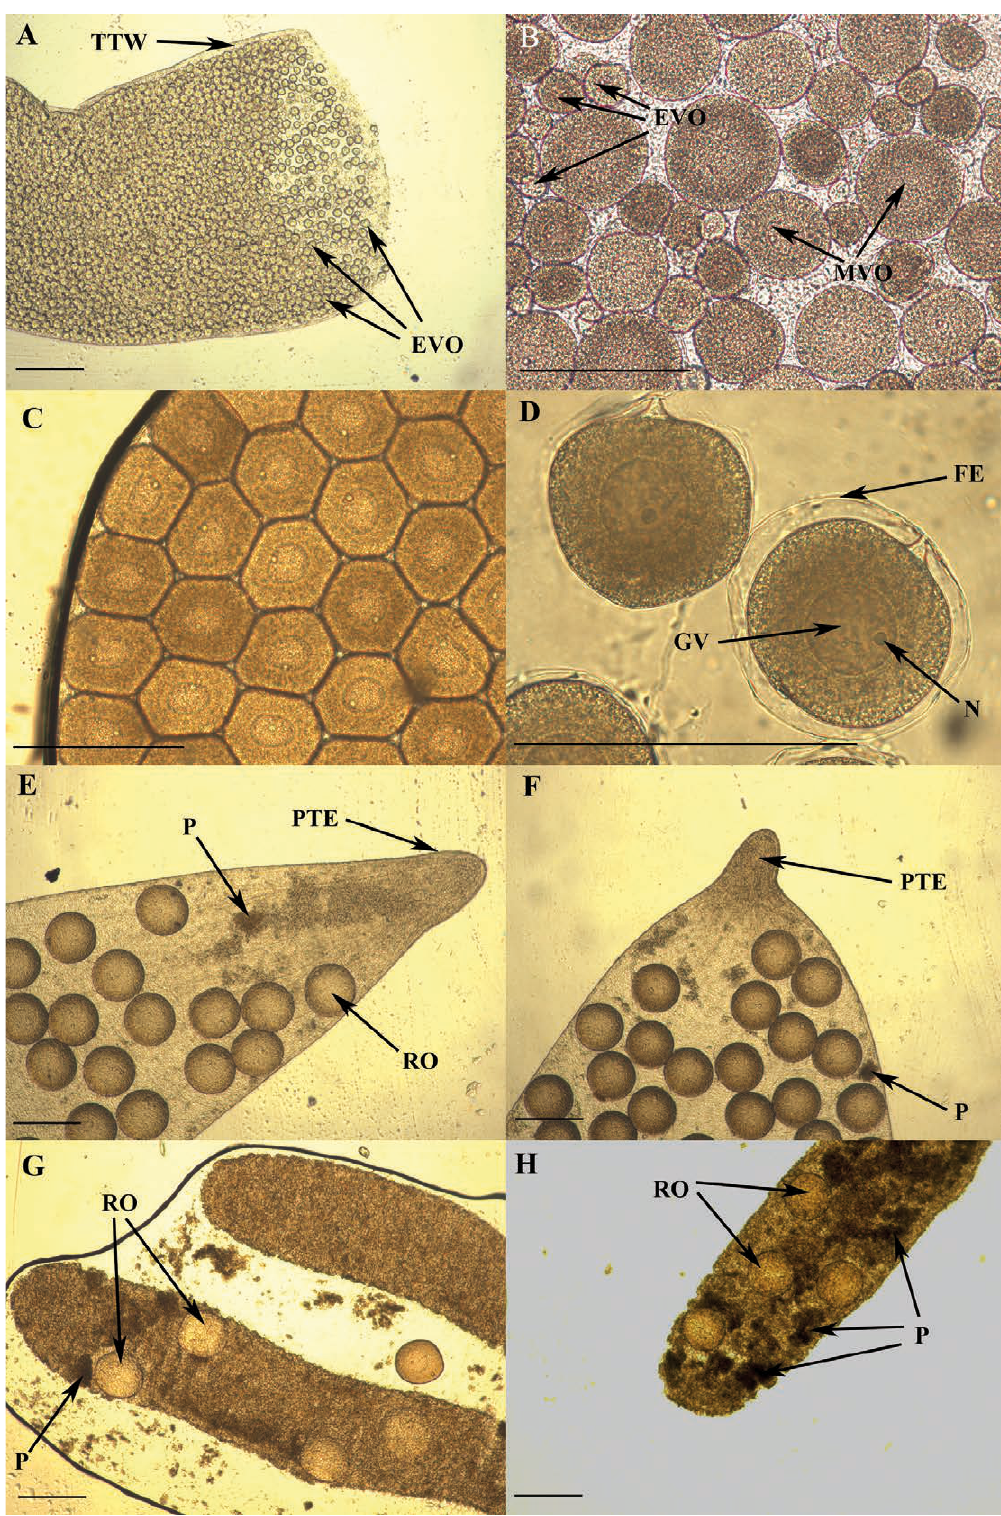
Fig . 7. – Light micrographs of female H. sanctori stages of maturity. A, growing tubule with early vitellogenic oocytes (EVO) and with thick tubule walls (TTW); B, tubule with early (EVO) to mid-vitellogenic oocytes (MVO); C, tubule completely full of late vitellogenic mature oocytes; D, mature oocytes, with nucleus (N), germinal vesicle (GV) and follicular epithelium (FE); E-F, partly spawned tubules with pres- ence of relict oocytes (RO), phagocytes (P) and with pointed tubule end (PTE). G-H, totally spent tubules with phagocytes (P) and few relict oocytes (RO). Scale bars: 250 µm; A-B, stage II; C-D, stage III; E-F, stage IV; G-H, stage